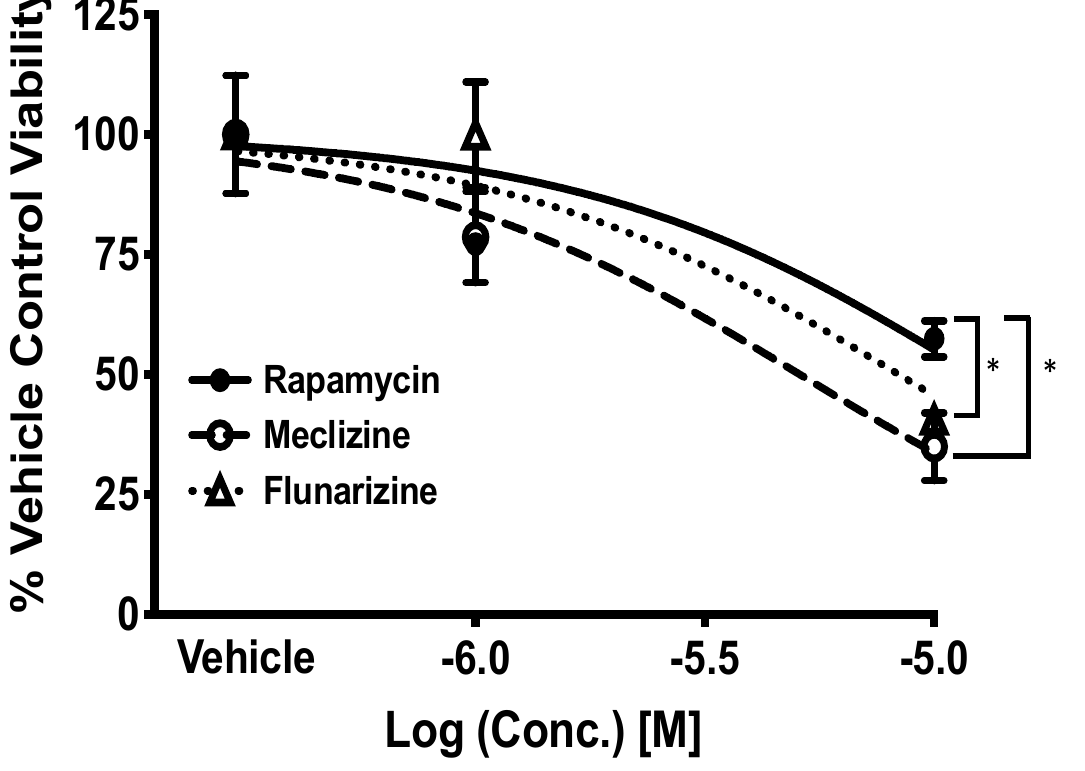
Figure 4. Meclizine and flunarizine dose-dependently kill patient-derived GBMSC better than rapamycin. Experiments were completed used Trypan Blue Exclusion. Values are cell viability at 1 µM (–6.0) and 10 µM (–5.0) of rapamycin, meclizine, and flunarizine. Error bars are the standard error of the mean. A significant difference for meclizine v. rapamycin and flunarizine v. rapamycin at 10 µM p < 0.05 was observed, this is represented by *. p -values were calculated using the two-tailed t- test. Lines are nonlinear sigmoidal dose–response curves fitted by the three-parameter model. n = 6 for vehicle, n = 4 for each concentration rapamycin, n = 6 for each concentration of meclizine, and n = 3 for each concentration of flunarizine. The total number of measurements was 6, 8, 12, and 6 for